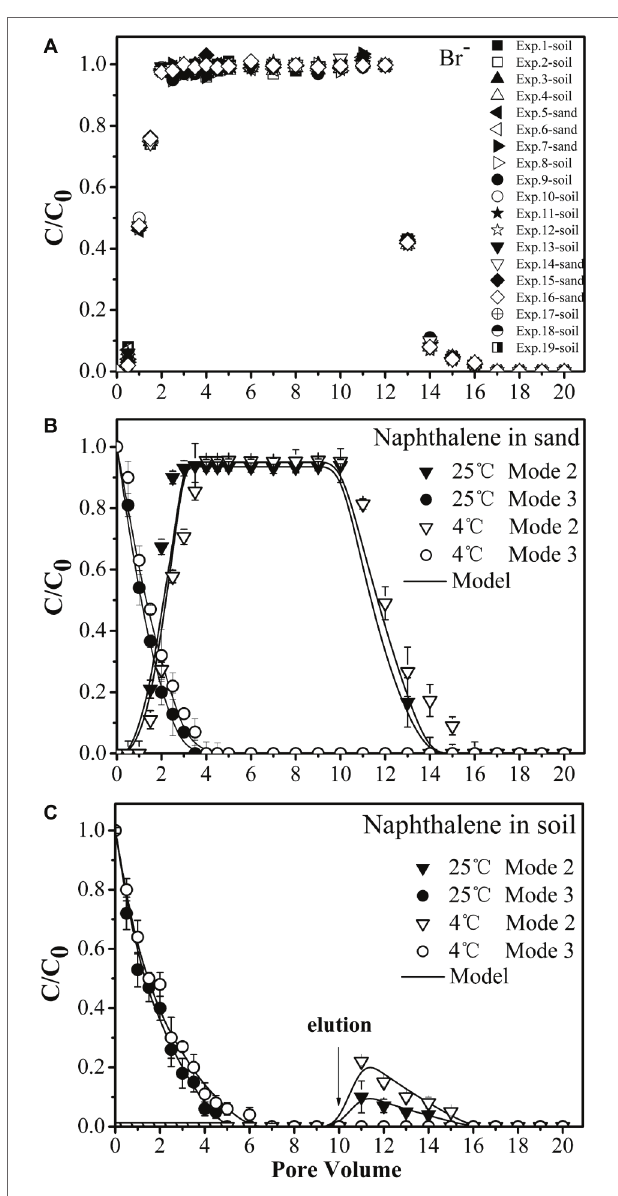
FIGURE 5 | Transport of bromide (Br − 1 ) (A) and naphthalene through sand (B) and soil (C) columns during injection of bacteria. Input modes are described in Figure 4 . Mode 2, co-injection of bacteria and naphthalene; Mode 3, injection of naphthalene immediately followed by injection of bacteria. Error bars represent the standard deviation of two